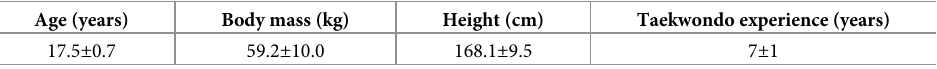
Table 1. Characteristics of the participants (values are mean ± standard deviation; n =